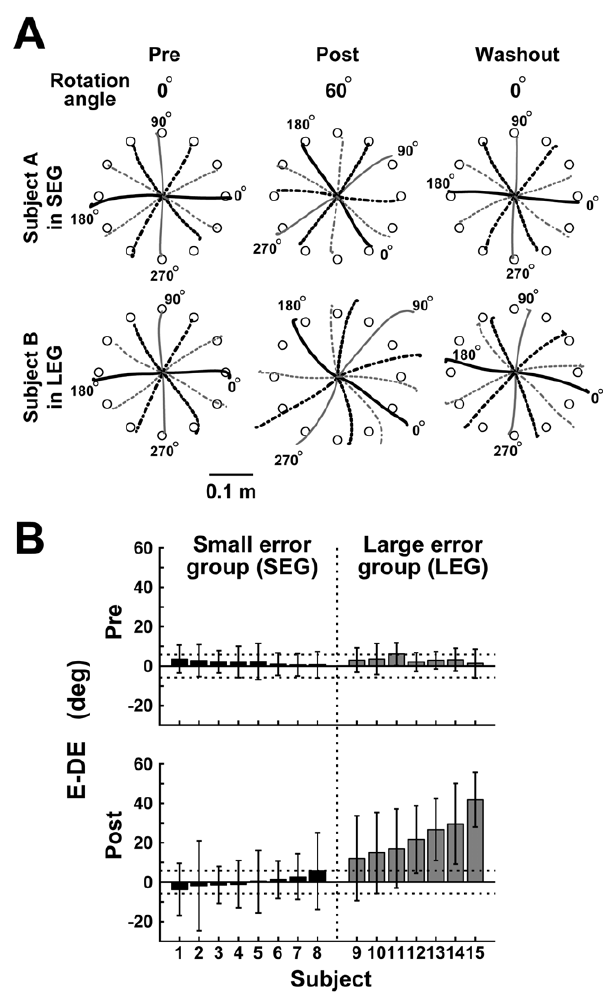
Figure 6. Reaching performances in the gradual visuomotor rotation learning without online cursor feedback. A , Averaged hand trajectories of typical subjects in the pre-training (left panels), post-training (middle panels), and washout phases (right panels) of the ‘‘without online cursor feedback’’ condition (experiment 2). Upper and lower panels correspond to the trajectories of typical subjects in the small error group (SEG) and large error group (LEG), respectively. Small white disks in each panel indicate the reaching target locations. The hand was moved from the center outwards. The trajectories are averaged 1 sec from the reaching onset in each reaching direction. The angles placed aside of the endpoint of the trajectories indicate the directions of the visual targets. B , Averaged E-DE in pre- and post- training phases for all subjects. Error bars denote the SD. Dashed lines indicate the reaching success margin ( 6 5.7 u , see Data analysis). DE, C, and ED) of the LEG (orange lines) increased progressively